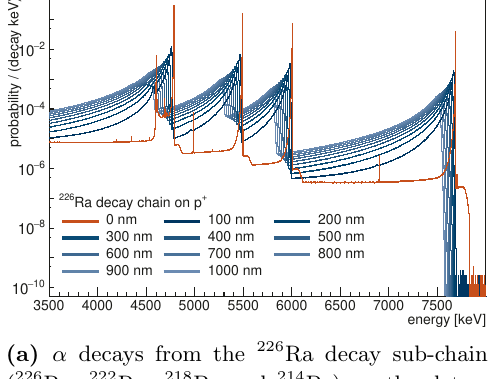
Figure 11. PDFs in the full energy domain. All PDFs are normalized to the number of simulated primary